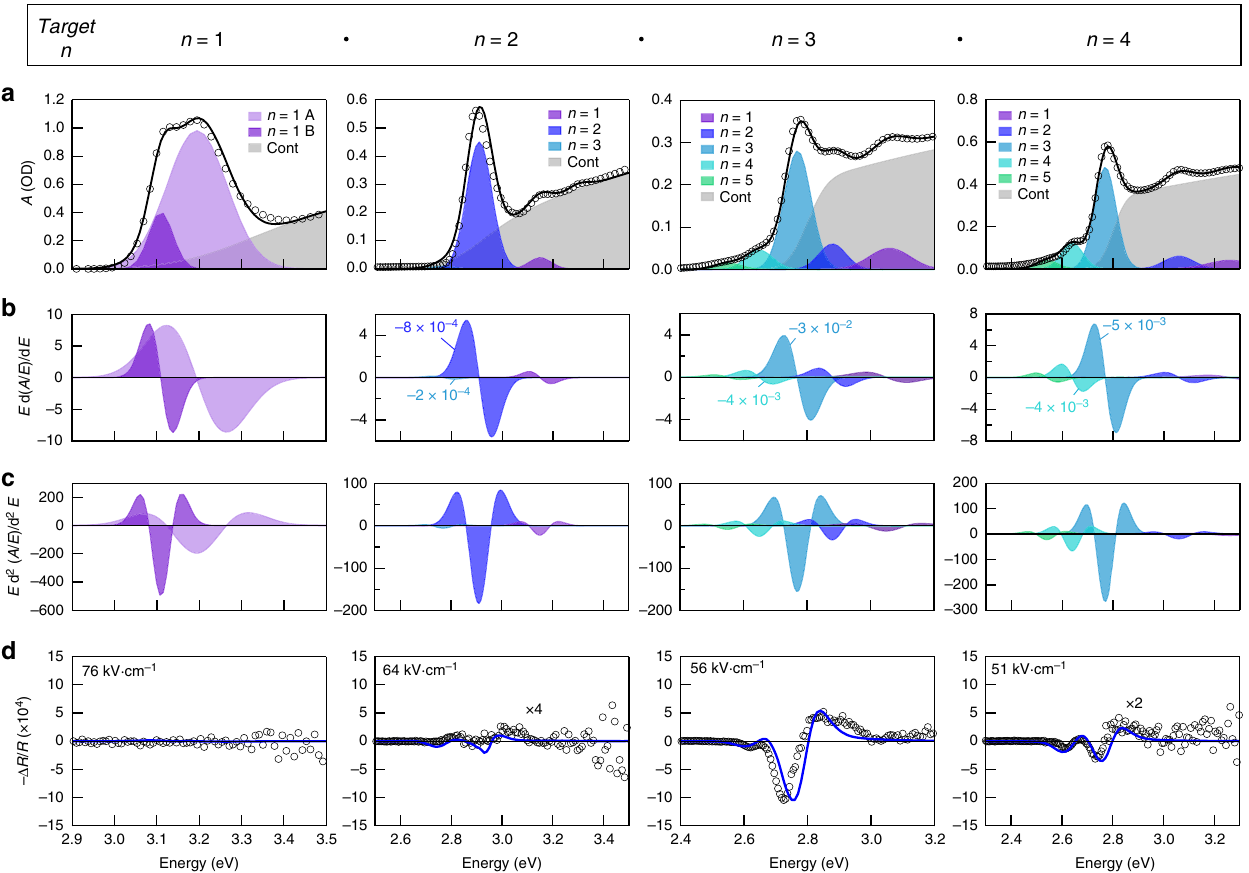
Fig. 2 Well width-dependent electroabsorption. a Optical absorption spectra for perovskite nanoplatelets (methylammonium and hexylammonium organic cations) fi t with bound and continuum exciton transitions (see Methods for details). Open circles are experimental data points. The total fi t is provided as the solid black line. The target well width increases from left to right, and is labelled above each column. The splitting of the exciton resonance for the n = 1 sample is attributed to previously observed phonon sidebands 43,98 . b First-derivatives of the excitonic contributions in the optical absorption; correlation with electroabsorption indicates energetic shifts. c Second-derivatives of the excitonic contributions in the optical absorption; correlation with electroabsorption indicates broadening. d Electroabsorption spectra of each sample (open circles). Spectra for n = 2 and n = 4 have been enlarged by the factors given. Blue curves are fi ts from transfer matrix modelling of changes to the complex dielectric function based on weighted-sums of the zeroth-, fi rst- , and second-derivatives of the excitonic absorption bands (see Methods and Supplementary Figures 3 – 8). The weights of the main contributions are indicated in b . Electric fi eld strengths indicate those applied to the nanoplatelet